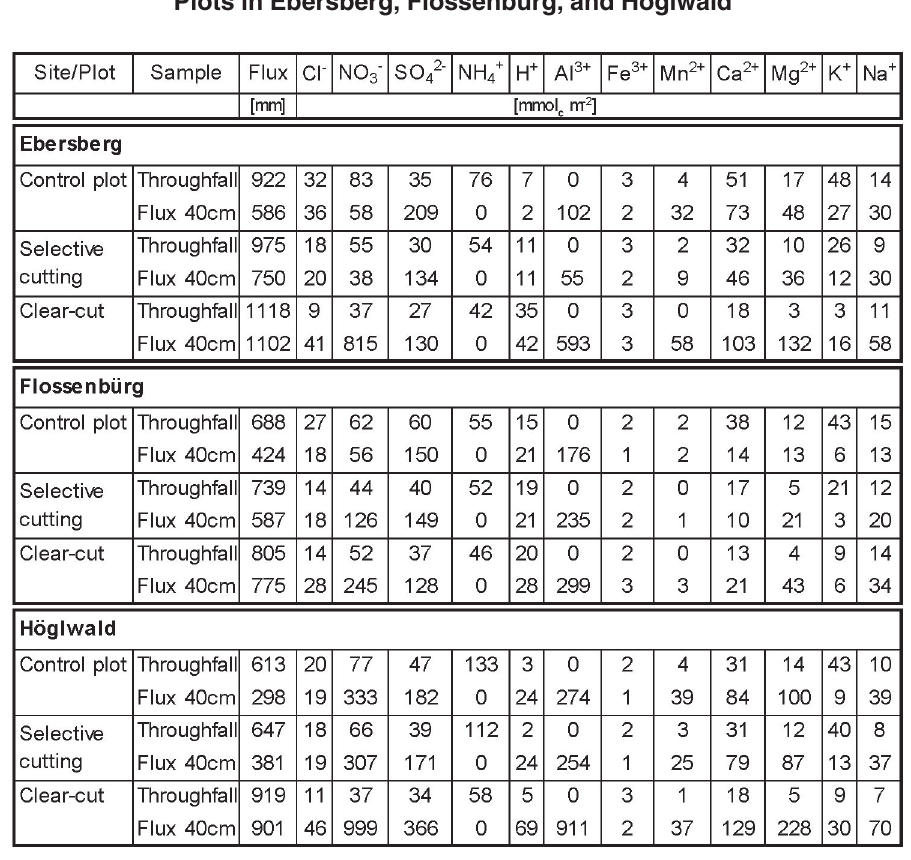
Annual Water and Ion Fluxes for Control, Selective-Cutting, and Clear-cut Plots in Ebersberg, Flossenbürg, and